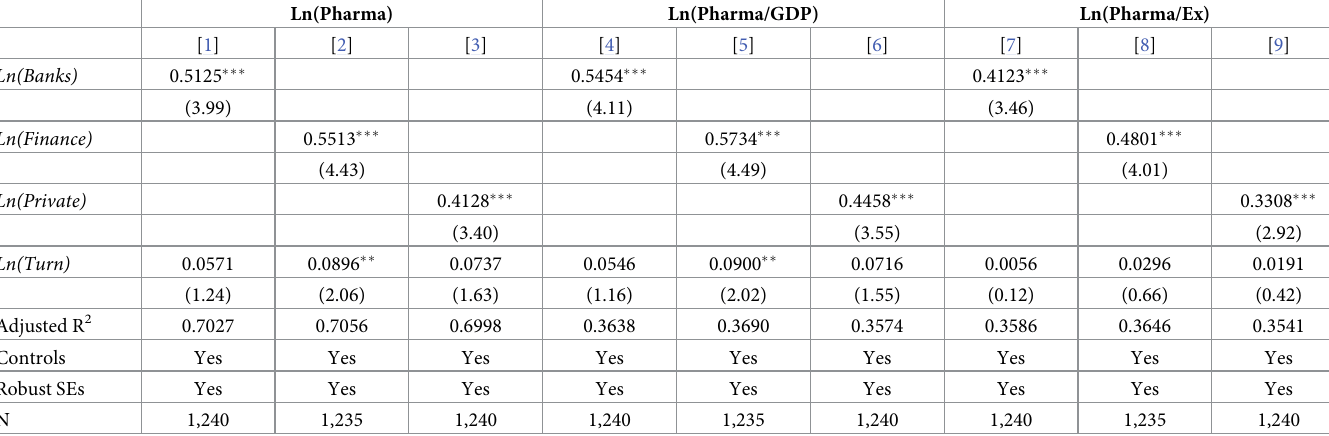
Table 5. Pharmaceutical innovation and both credit and equity market